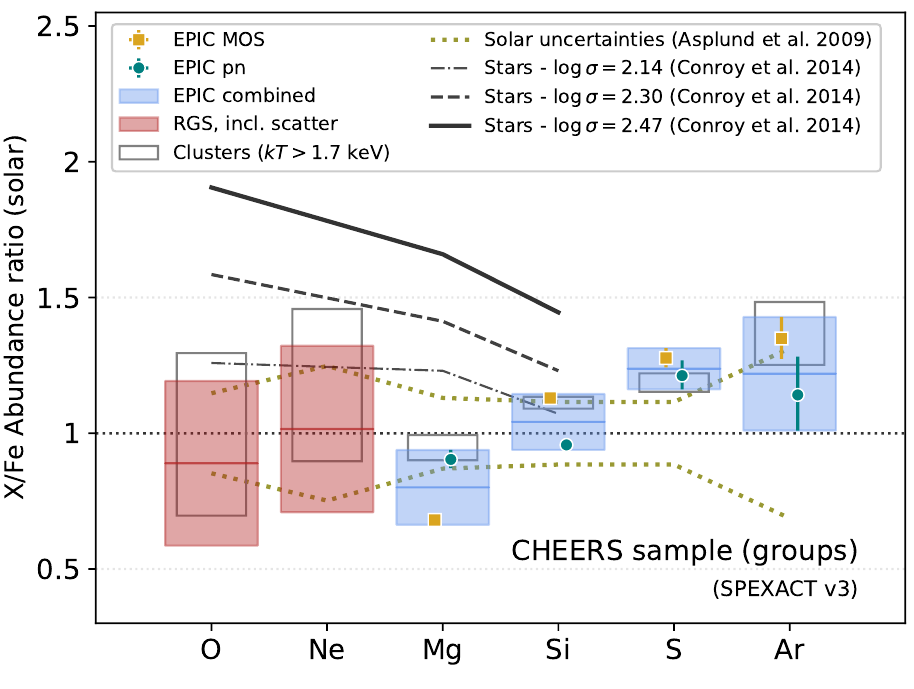
Figure 5. Average chemical composition (expressed as X/Fe abundance ratios in units of Reference [43]) within the central 0.05 r 500 of the 21 galaxy groups and massive ellipticals from the CHEERS sample (defined as kT mean < 1.7 keV). The O/Fe and Ne/Fe ratios (including their intrinsic scatter) were measured using the XMM- Newton RGS instruments, while the other ratios are measured using the XMM- Newton EPIC MOS and pn instruments. To be conservative, the EPIC ”combined” measurements cover the entire MOS-pn discrepancies, which fully accounts for the intrinsic scatter, as well. Comparison with the average chemical composition of clusters shows values that are similar and near-Solar in both regimes. For comparison, Solar uncertainties are also shown, as well as stellar abundances in ETGs measured for different bins of stellar velocity dispersion σ [129]. Adapted from Mernier et al.